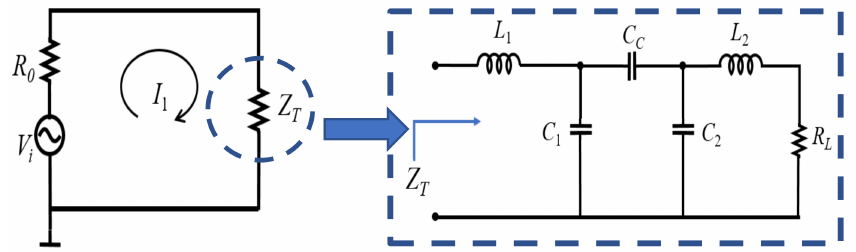
Figure 4. A simplified circuit of the S-CPT circuit.